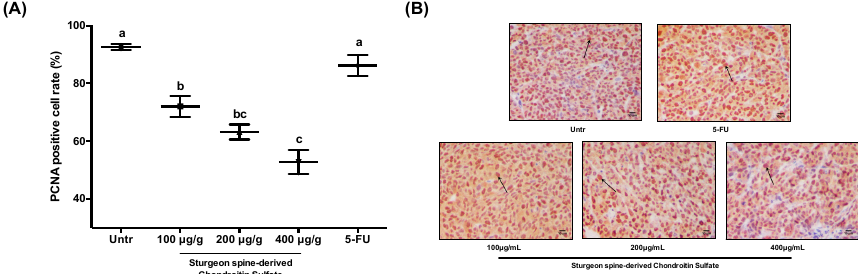
Figure 6. E ff ect of SCS on cell proliferation in HCT-116 xenograft tumor mice model. Xenograft tumor tissues were collected after sacrifice and sectioned for proliferating cell nuclear antigen (PCNA) staining. ( A ) Percentage of PCNA-positive cells, ( B ) Representation images of PCNA staining. All results are expressed as mean ± SEM ( n = 10). Di ff erent superscript letters for each column indicate significant di ff erences ( p < 0.05) as compared to every other